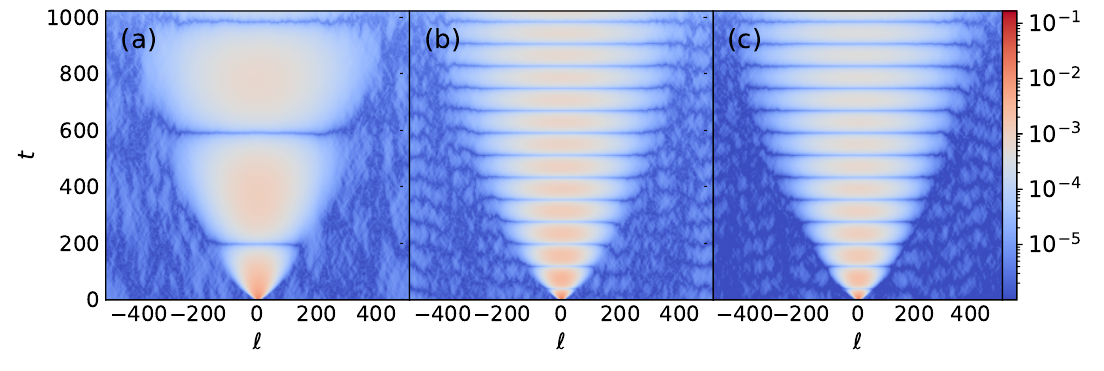
(cid:80) n X a ) (cf. a a = 10 3 , and L = 2 10 ). s ( N , k ) λ × 10 2 A × 10 2 A × 10 2 f i B